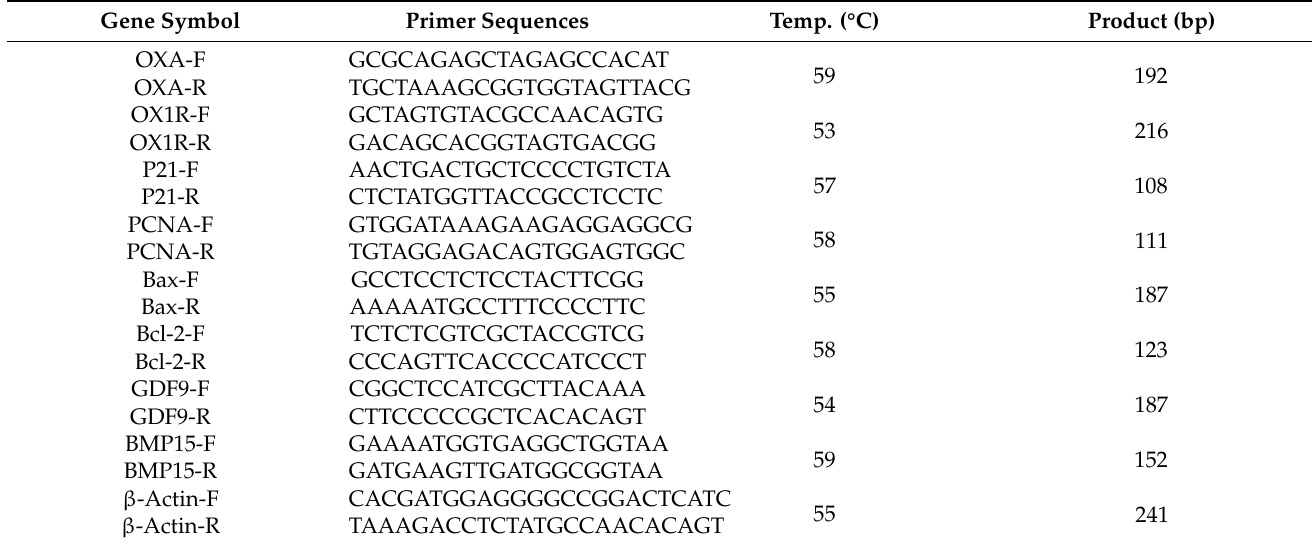
Table 2. The sequences of primers used for